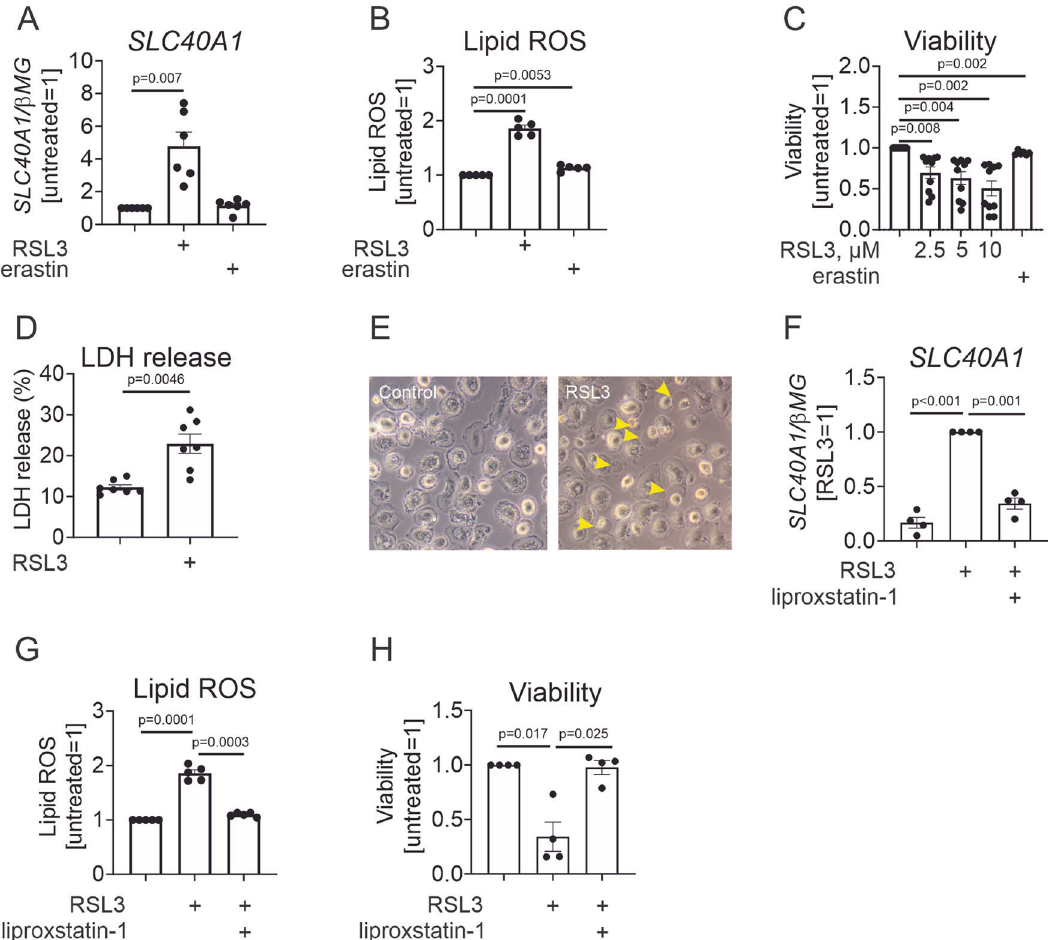
Fig. 1 RSL3 induces ferroportin gene expression and ferroptosis in human macrophages. A mRNA expression of SLC40A1 in M Φ exposed to 10 µM RSL3 for 24 h. B Lipid ROS levels in M Φ treated with 10 µM RSL3 or 10 µM erastin for 6 h. C Viability of M Φ exposed to indicated concentrations of RSL3 or 10 µM erastin for 24 h. D , E LDH release and morphology of M Φ treated with 10 µM RSL3 for 24 h. Arrowheads indicate membrane blistering. F – H SLC40A1 mRNA expression ( F ), lipid ROS ( G ), and viability ( H ) of M Φ treated with 10 µM RSL3 in the presence or absence of 250 nM liproxstatin for 6 h ( G ) or 24 h ( F , H ). Data are presented as means ± SEM ( N ≥